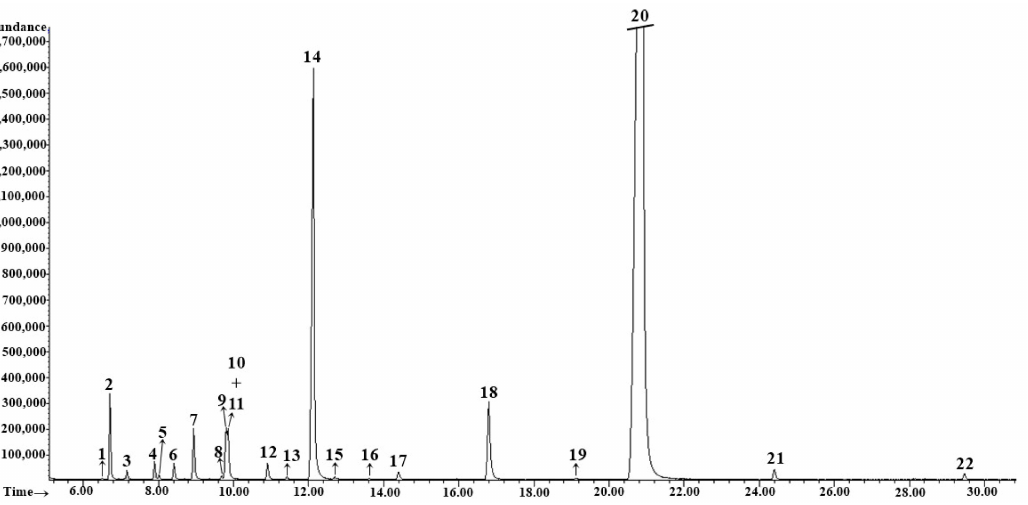
Figure 5. GC/MS chromatogram of essential oil isolated from wild fennel (4th stage: seeds